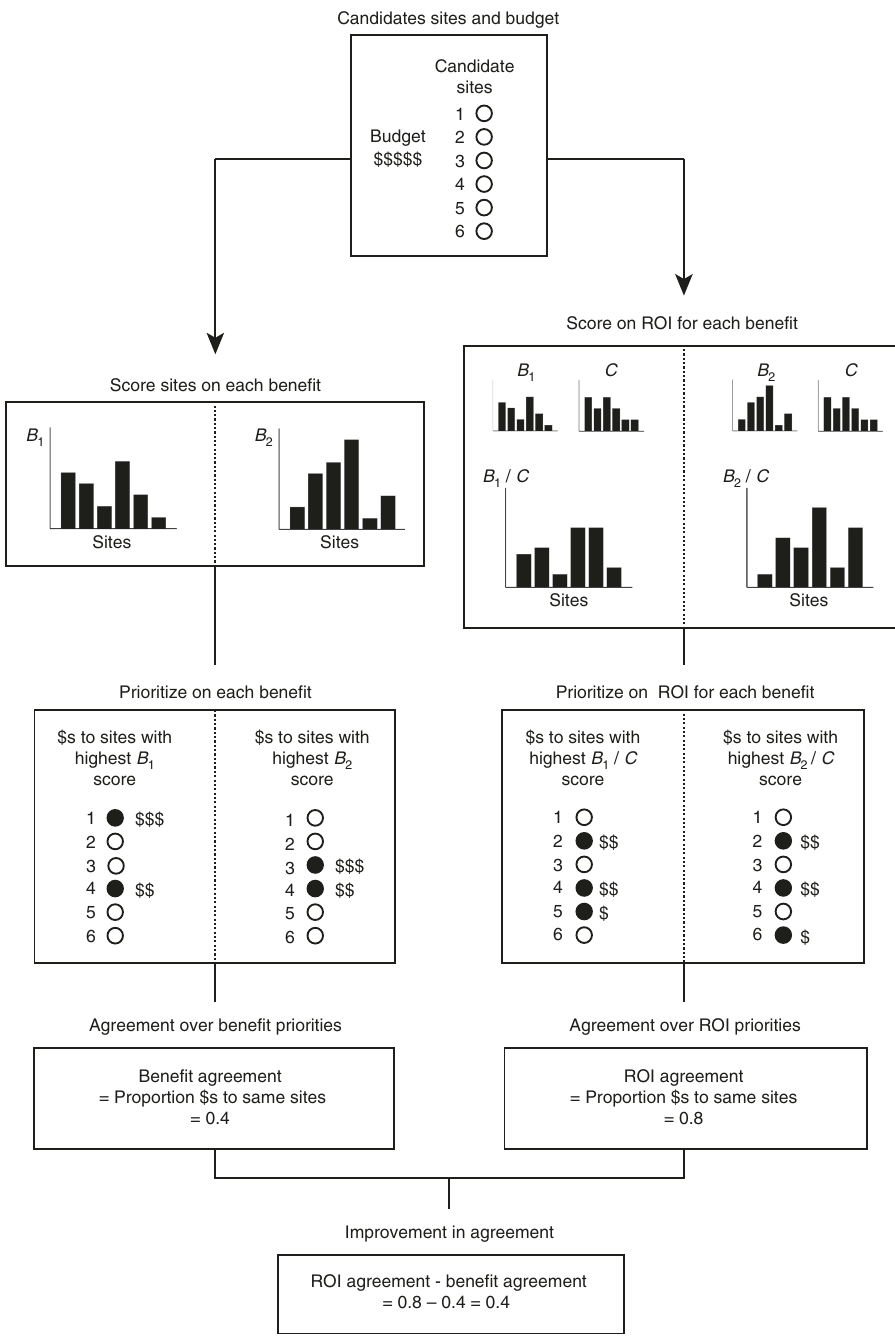
Fig. 1 Illustration of the steps in the analysis. Once a set of candidate sites for protection and budget level are established, candidate sites are ranked for protection using two different ecological bene fi t metrics B 1 and B 2 and the agreement level between the two prioritizations is calculated as the share of the budget allocated to the same set of sites. This process is repeated when ranking sites for protection using conservation return-on-investment, B 1 / C and B 2 / C , respectively. Finally, the levels of agreement between the bene fi t-only prioritizations and the ROI-based prioritizations are